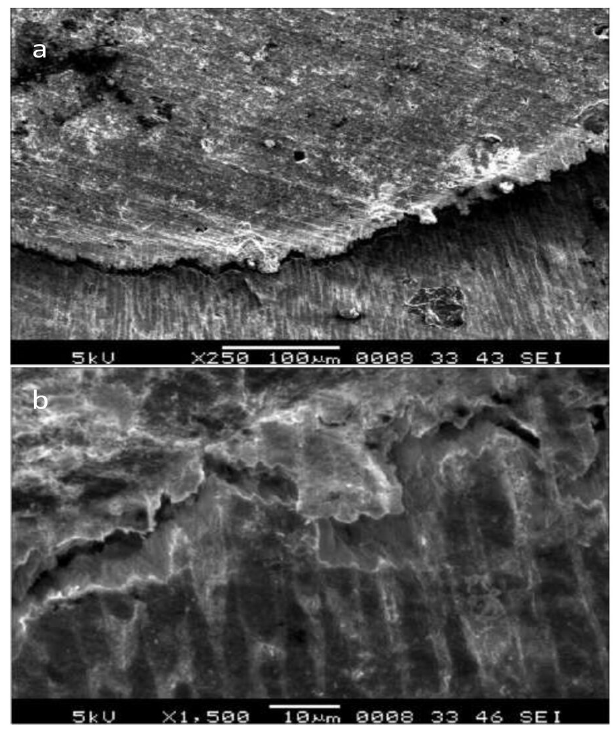
Figure 10. SEM images of a buccolingual section showing ( a ) a white zone at the tooth surface-sealant interface and ( b ) a white irregular granular zone at the tooth surface-sealant interface [151].